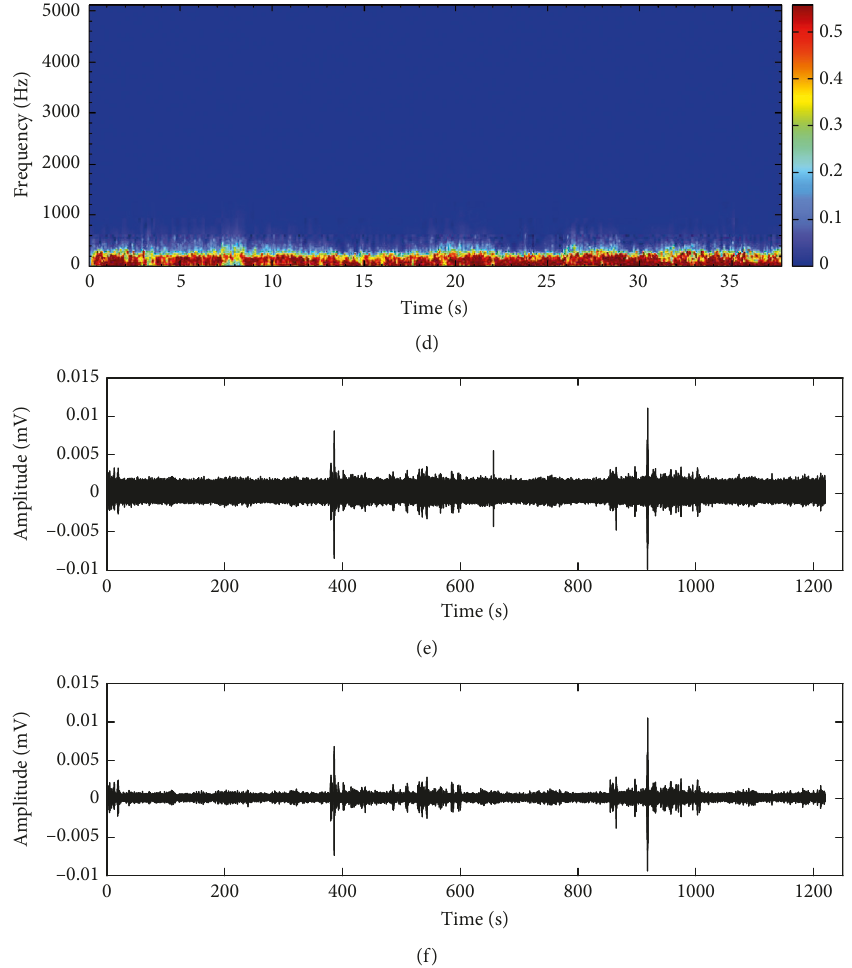
Figure 11: Original microseismic signals and denoised signals collected in the experiment: (a) signal before denoising during excavation; (b) denoised signal during excavation; (c) signal spectrum before denoising during excavation; (d) denoised signal spectrum during excavation; (e) original signal during waiting time; (f) signal after denoising during waiting